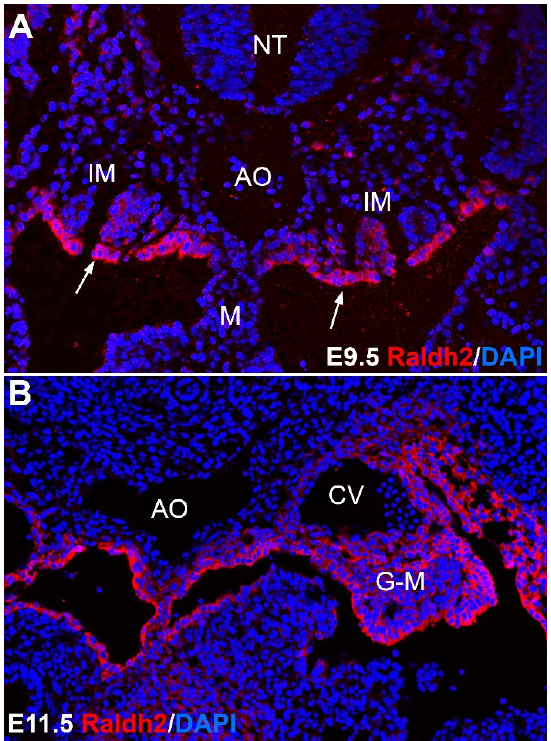
Figure 3. Vitamin A in developmental hematopoiesis. The picture shows immunolocalization of the enzyme RALDH2, catalyzing a key step in the generation of retinoic acid from retinol in the aorta-gonad-mesonephros. RALDH2 is expressed in the coelomic epithelium of the intermediate mesoderm (IM) (arrows in A) by the stage E9.5 ( A ) and later ( B ) in mesenchymal cells of area, where the definitive population of hematopoietic stem cells is generated, between the aorta (AO), the cardinal veins (CV) and the gonadal/mesonephric mesoderm (G-M). This embryonic RA signaling is essential for the emergence of the definitive blood progenitors, as described in the text. M: mesentery; NT: neural